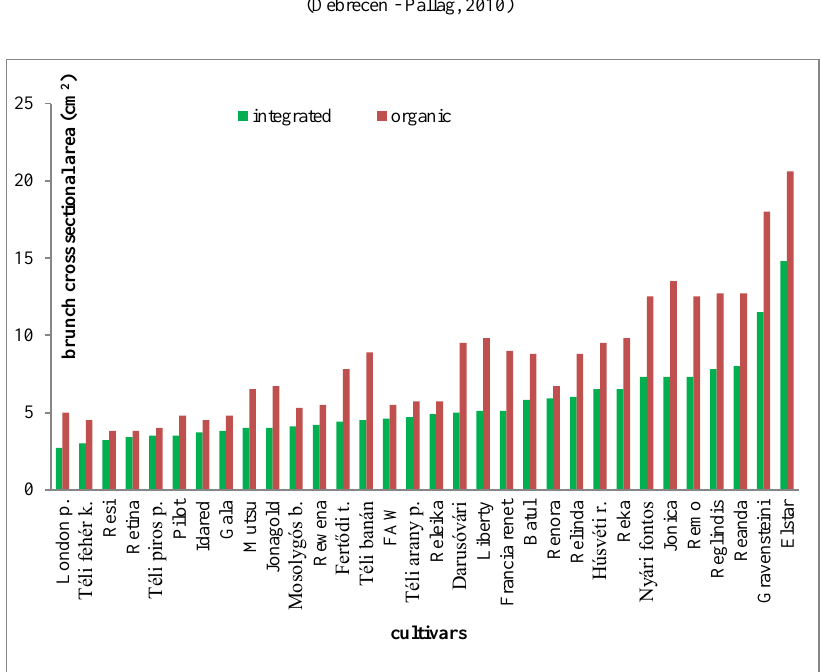
Figure 2. Cross sectional area of branches in the middle region of apple trees aged 14 (Debrecen - Pallag,